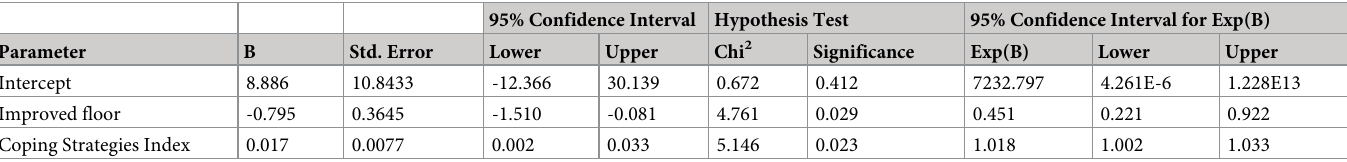
Table 5. Table reporting final parameters included in multivariable regression analysis for risk of functional